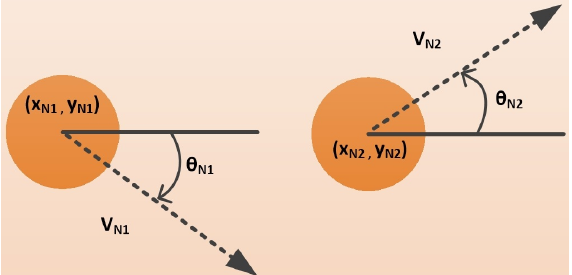
Figure 5. Parameters used for calculating Link Expiration Time (LET) between two nodes.